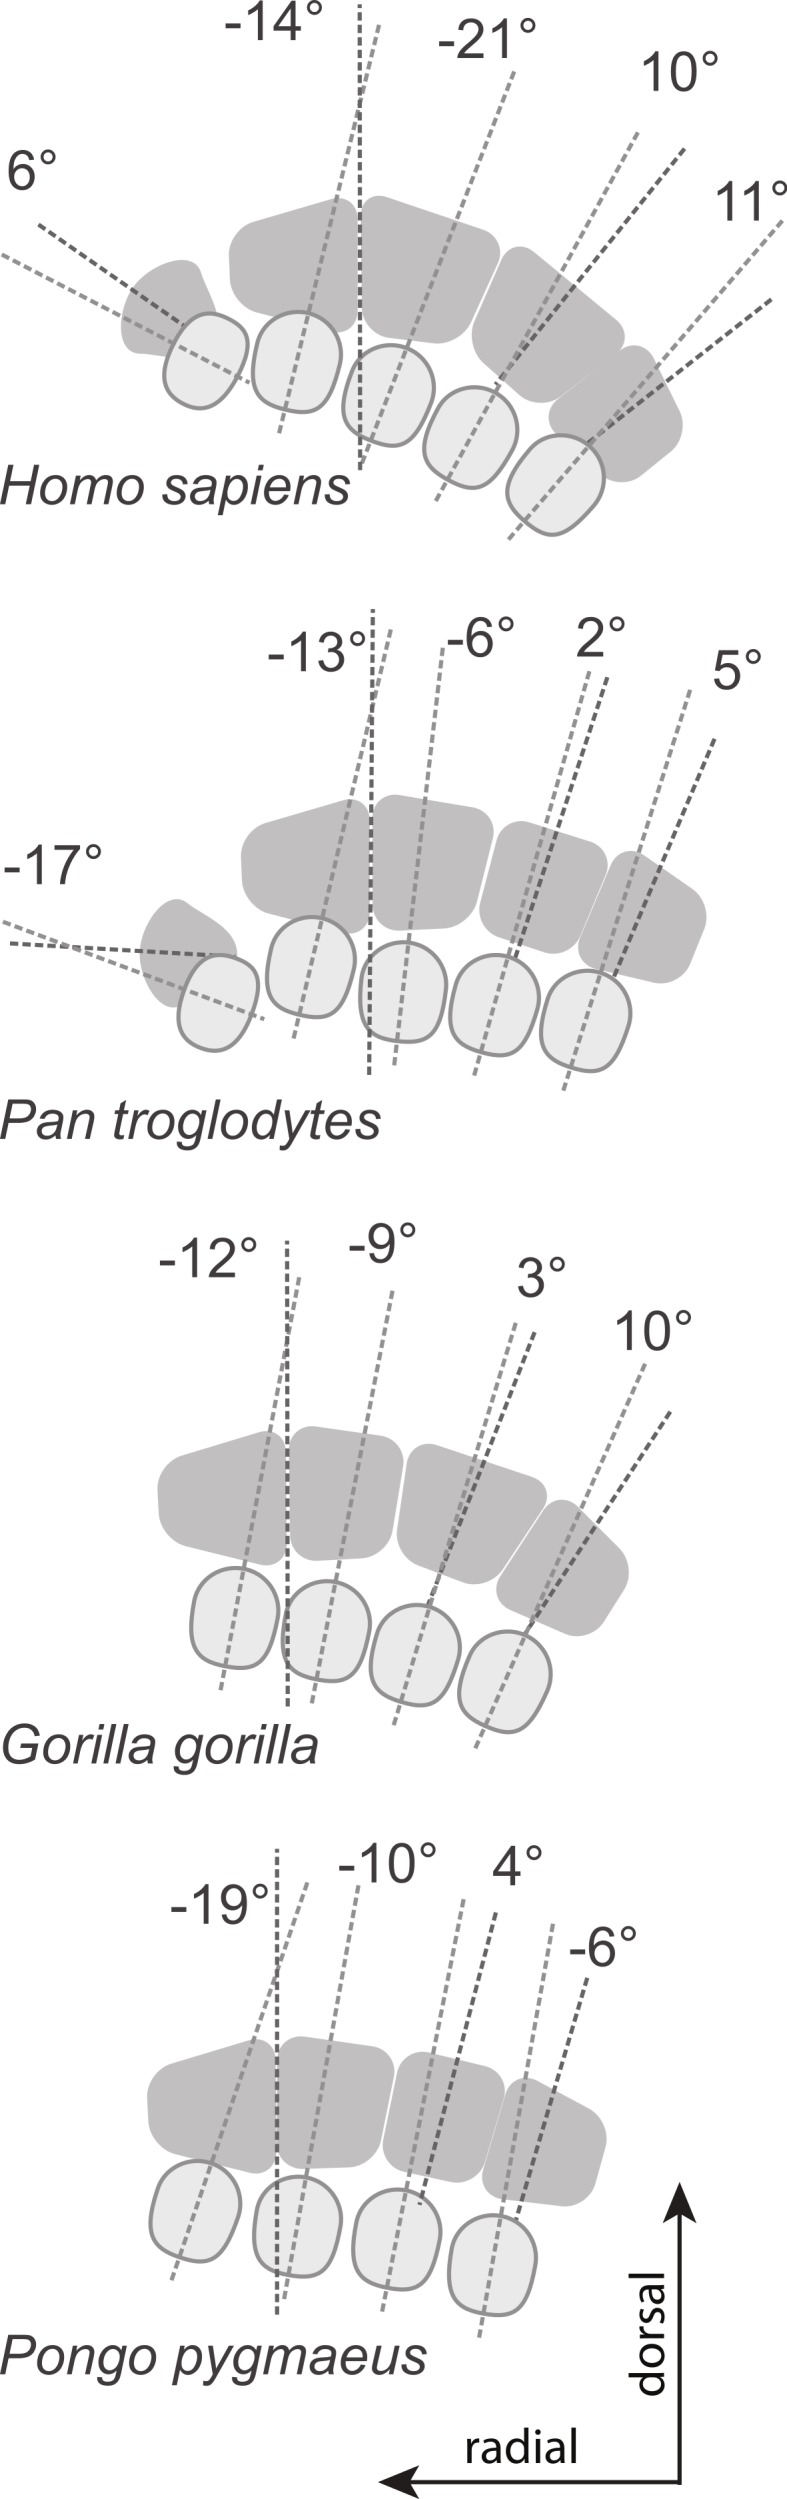
Metacarpal base and heads with average torsion values.Metacarpal head (pale grey ovals) and base (dark grey quadrangles) of a left hand with the plantodorsal axes drawn (pale grey dotted line for the head; dark grey for the base; see methods for details). Metacarpal torsion is measured as the angle between these two axes in the coronal plane. The average torsion values are drawn from Table 2 and average wedging values of the MC3 and MC4 bases are drawn from Table 6. All drawings are aligned relative to the MC2-MC3 articulation. Relative orientation of the MC1 base (drawn for humans and chimpanzees only) is estimated from the orientation of the trapezio-MC articulation (from Fig. 20 in Sarmiento, 1994). Because of the strong wedging of the MC3 and MC4 bases, the dorso-palmar axis of the bases of the ulnar-most MCs of humans are more turned toward the thumb than in other taxa.